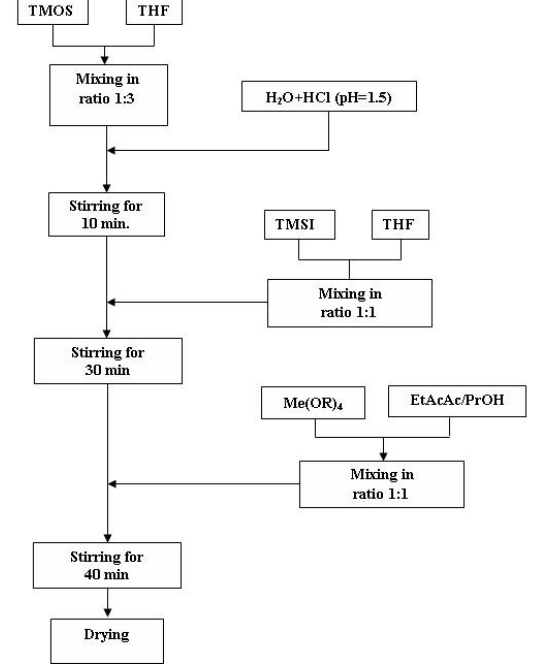
Figure 1. Schematic diagram for the synthesis of the hybrids materials containing Zr and